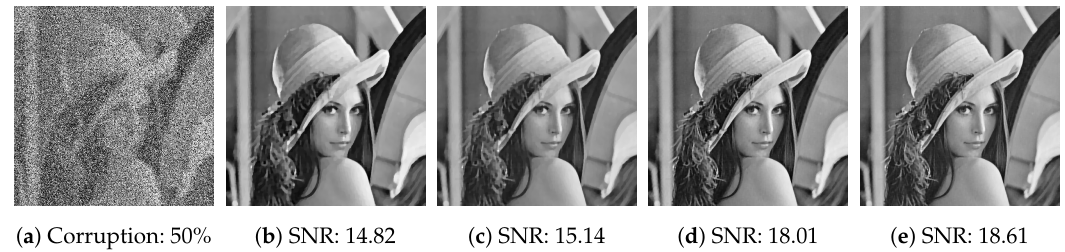
Figure 9. Comparisons of TVL1, HTVL1, CTVL1 and HOCTVL1 model on the Lena image corrupted by Gaussian blur and salt-and-pepper noise with noise level 50%. ( a ) Corrupted image. ( b ) TVL1 model. ( c ) HTVL1 model. ( d ) CTVL1 model. ( e ) HOCTVL1 model.